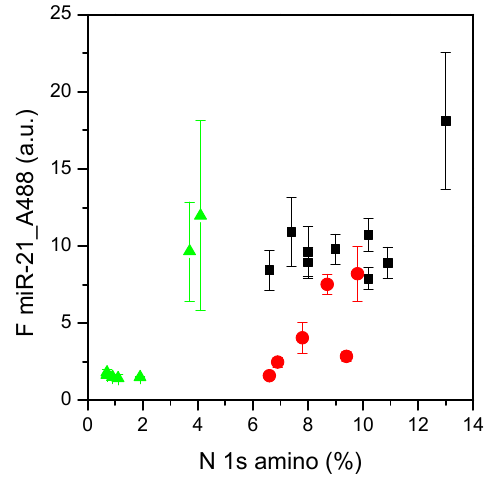
Figure 9. Correlation between miR-21 adsorption and amino nitrogen N 1s XPS components on all